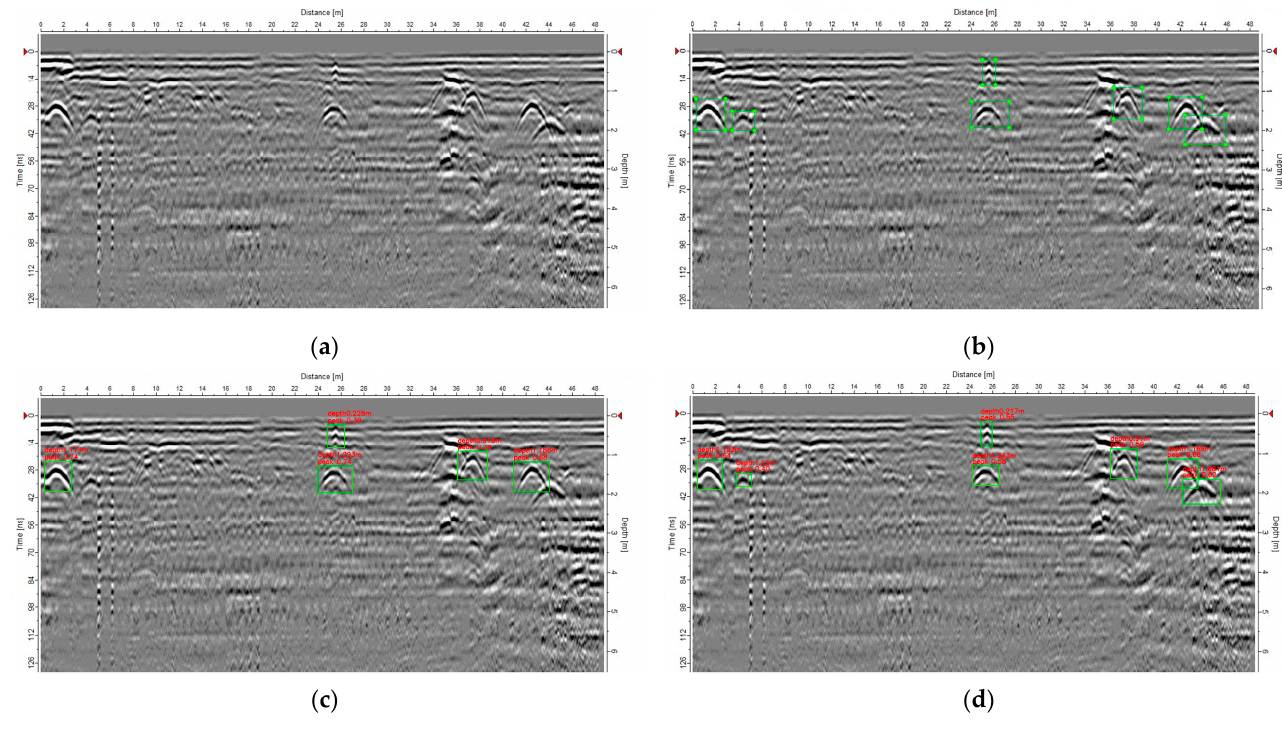
Figure 23. ( a ) Original image; ( b ) foreign objects expected to be detected; ( c ) foreign objects detected by the YOLOv5 algorithm; ( d ) foreign objects detected by the improved YOLOv5 algorithm.